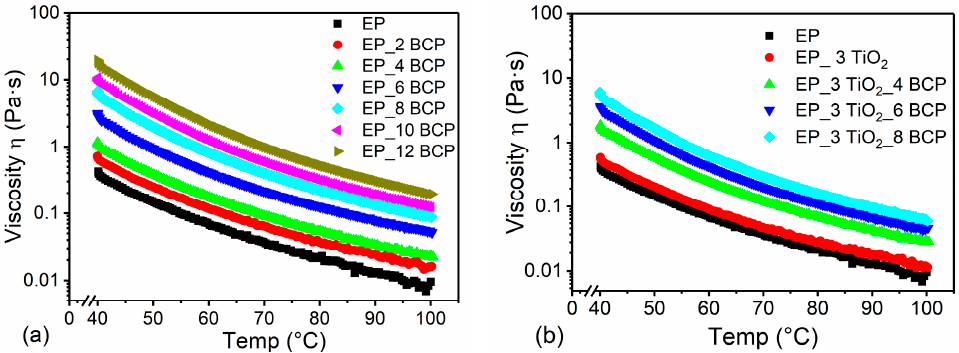
Figure 5 . Graph showing variation in viscosity with respect to temperature for ( a ) EP_BCP systems, and ( b ) EP_TiO 2 _BCP hybrid systems.